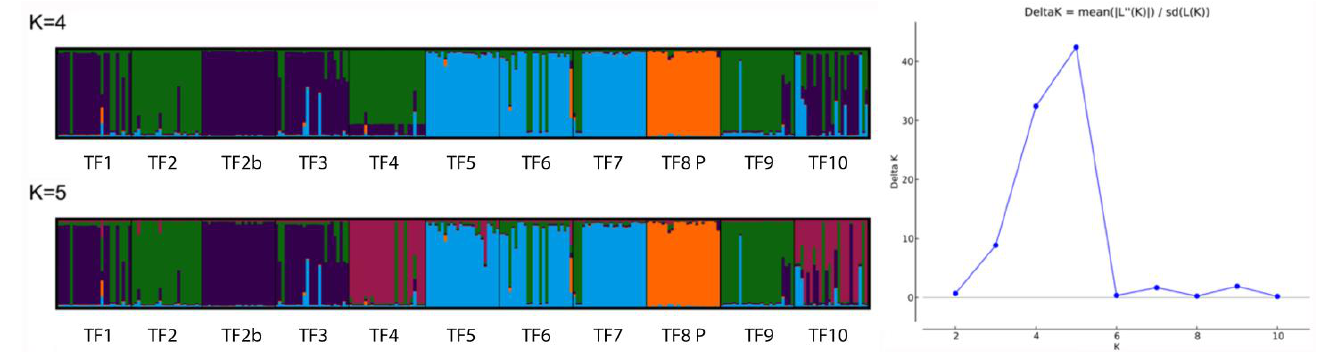
Figure 3. Neighbor-joining tree based on Nei genetic distances between populations. Numbers indicate bootstrap values (%).